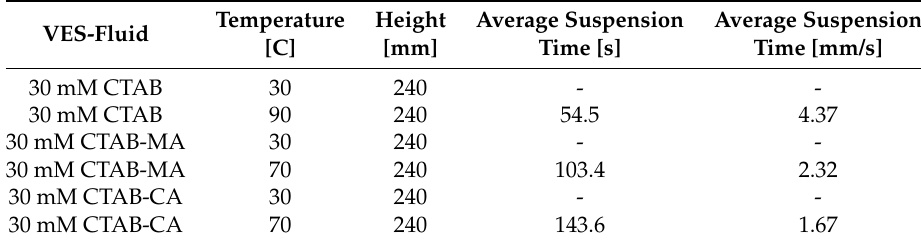
Table 1. Average sand suspension velocity of all VES fluids under different temperatures. Temperature VES-Fluid